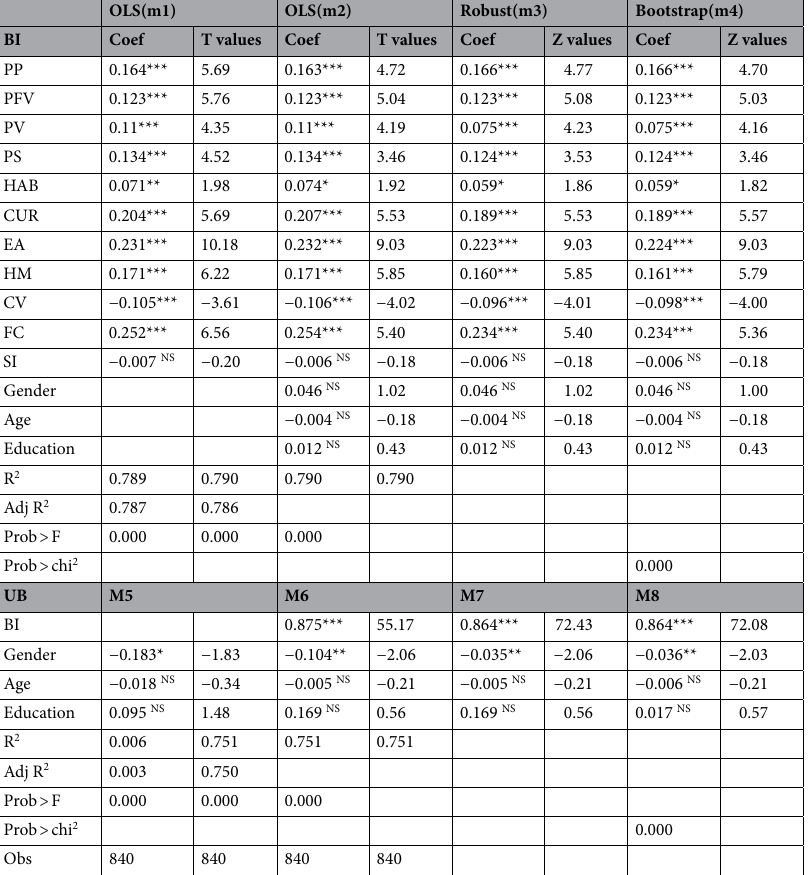
Table 5. Path Results. 1. *** p < .01, ** p < .05, * p < .1; NS = Not supported. 2. PP = Perceived Performance; PFV = Perceived Functional Value; PV = Perceived Value; PS = Perceived Satisfaction; HAB = Habit. Hedonic Motivation; CUR = Curiosity; SI = Social Influence; EA = Environmental Awareness; FC = Facilitating Condition; CV = Cost Value; BI = Behavioral Intention; UB = Usage